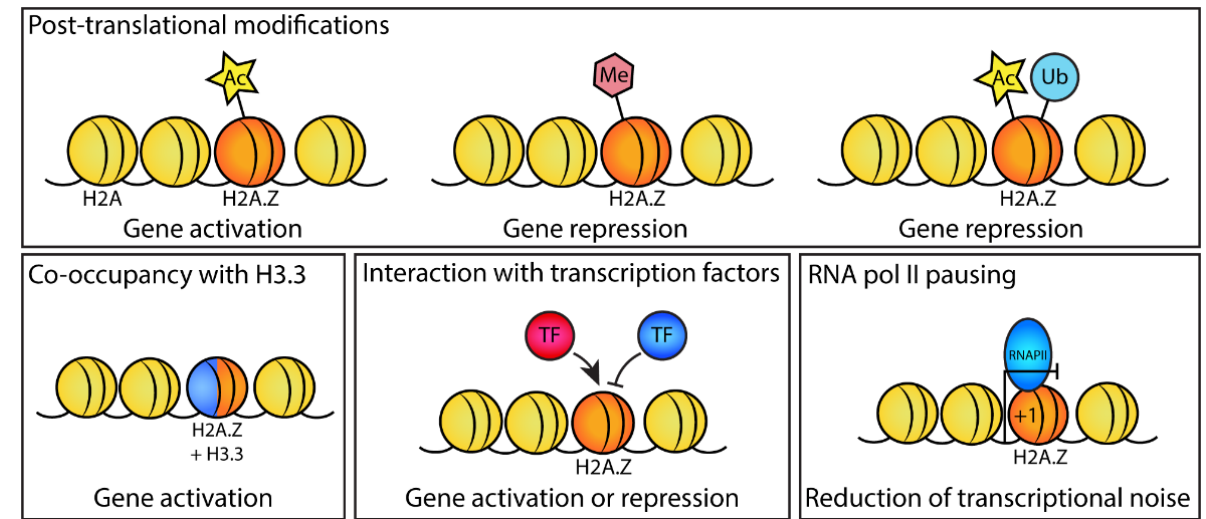
Figure 2. Mechanisms of H2A.Z in regulating gene expression during development. Different mechanisms by which H2A.Z affects gene expression during development, which include H2A.Z posttranslational modifications (acetylation, methylation, and ubiquitylation) that can promote or repress gene expression; the co-occupancy of H2A.Z with the histone variant H3.3, which in some cases can promote gene expression; the interaction of H2A.Z with stage-specific transcription factors (e.g., Nanog, CDX2, BRD2) to promote or repress their recruitment to chromatin; and inhibiting or dampening the transcription of active genes when H2A.Z is present at the +1 promoter nucleosome (the nucleosome directly downstream of the TSS) through promoting RNA pol II